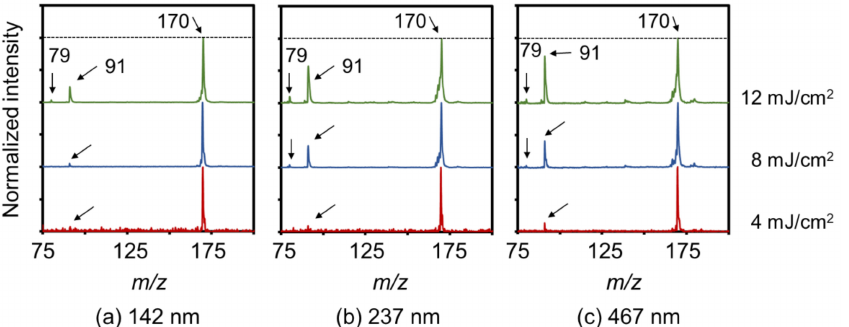
Figure 4. SALDI mass spectra of N-BP-Cl on the CNWs substrates with wall-to-wall distances of ( a ) 142 nm, ( b ) 237 nm, and ( c ) 467 nm, where the fluences of the incident laser light were set at 4, 8, and 12 mJ/cm 2 , respectively. All spectra were normalized with respect to the intensity at m / z = 170.